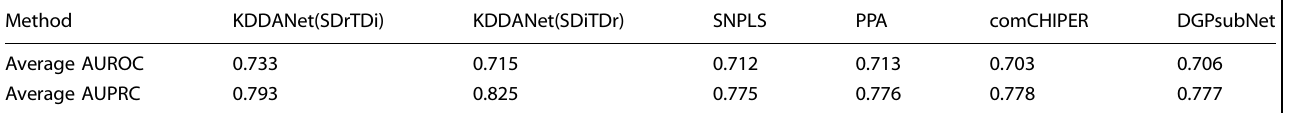
Table 1. Average AUC values of different computational tools for identifying hidden genes mediating